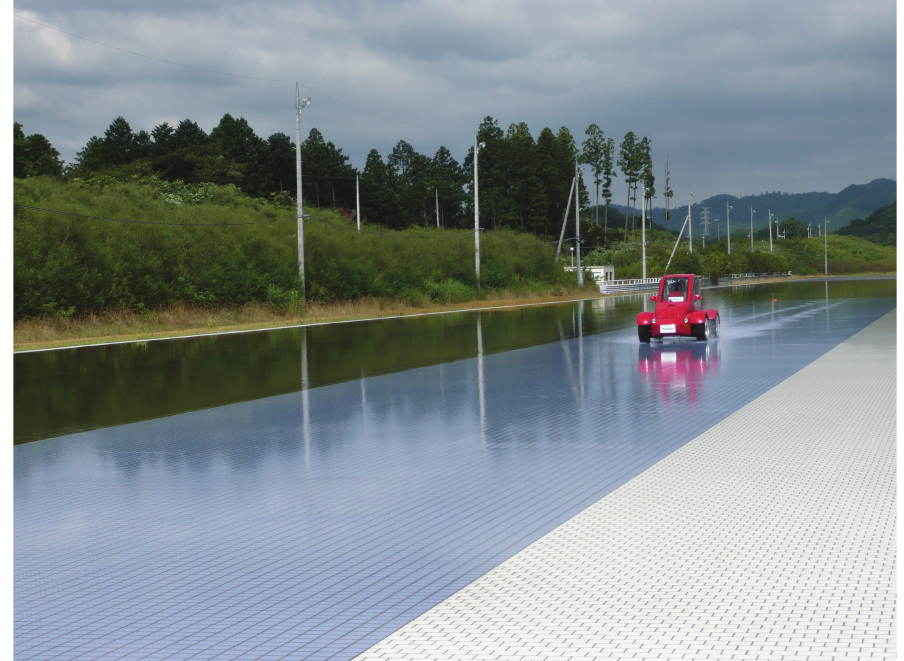
Figure 10. Field test on low- µ ground ( µ (cid:39) 0 . 3